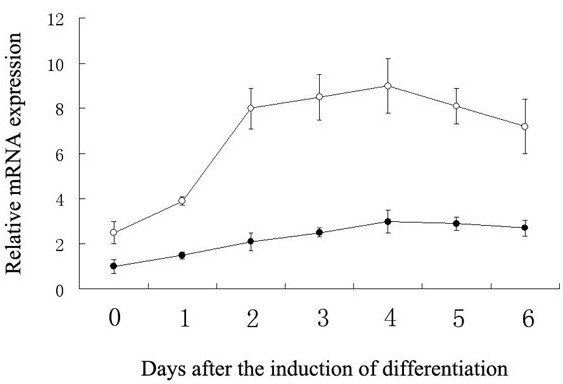
Real-time PCR analysis of CS1 and CS 2 mRNA expression during the myogenic differentiation of C2C12 cells (day 0 to day 7). Values are expressed as ratios of the basal transcription levels on culture day 0 for CS2.